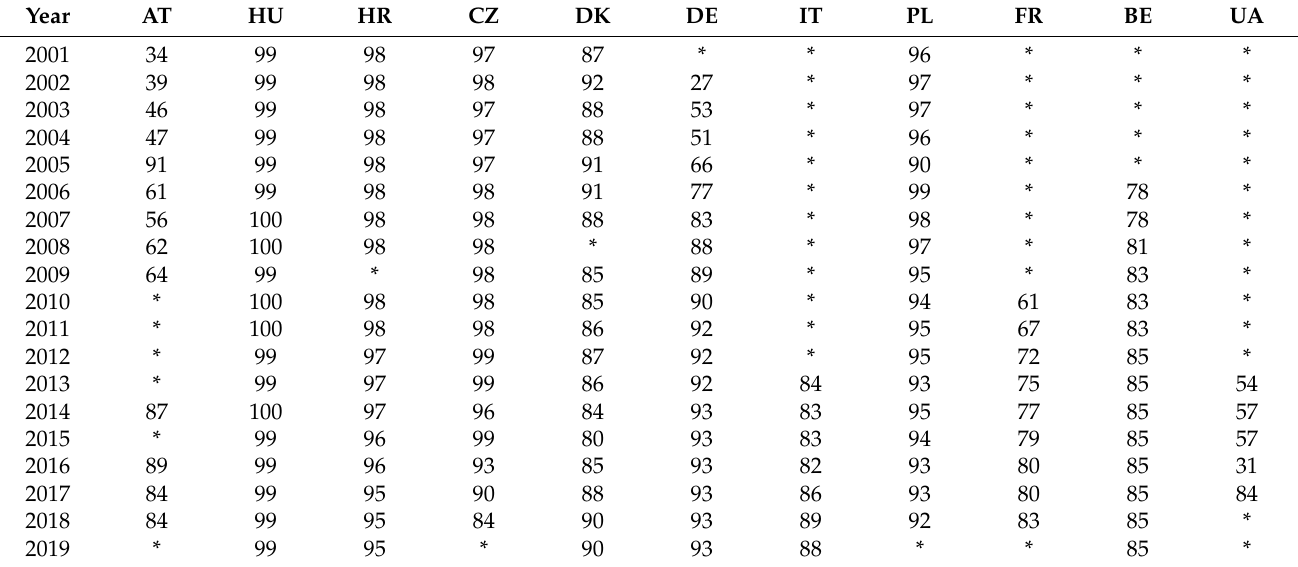
Table 6. Measles-containing revaccination (%) in selected European countries from 2001 to